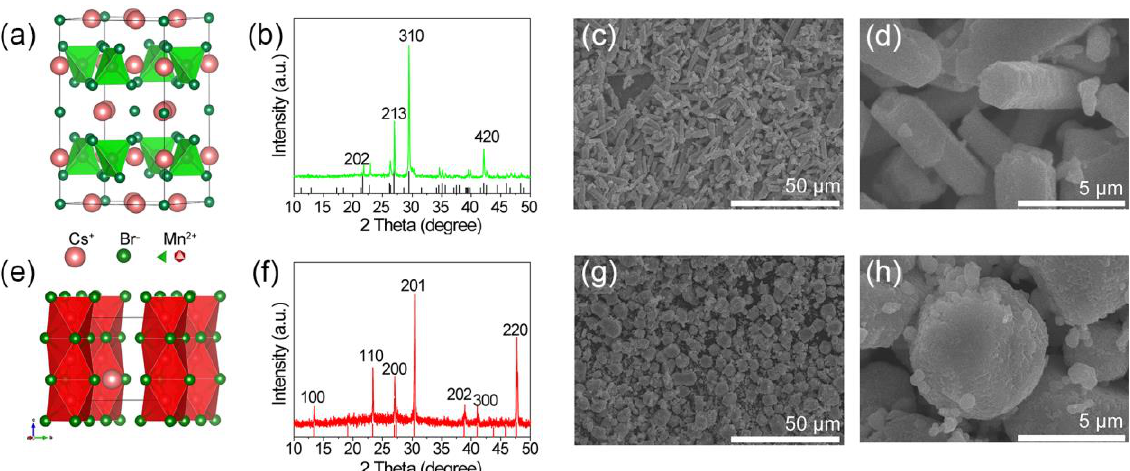
Figure 2. ( a , e ) Crystal structure of Cs 3 MnBr 5 (tetragonal, space group I4/mcm, a = 9.596 Å) and CsMnBr 3 (hexagonal, space group P 63/mmc, a = 7.618 Å); ( b , f ) XRD patterns of Cs 3 MnBr 5 and CsMnBr 3 (black) measured under ambient conditions, where the red columns at bottom are the standard patterns related to tetragonal Cs 3 MnBr 5 and hexagonal CsMnBr 3 ; low- and high-resolution SEM images of ( c , d ) Cs 3 MnBr 5 and ( g , h ) CsMnBr 3.